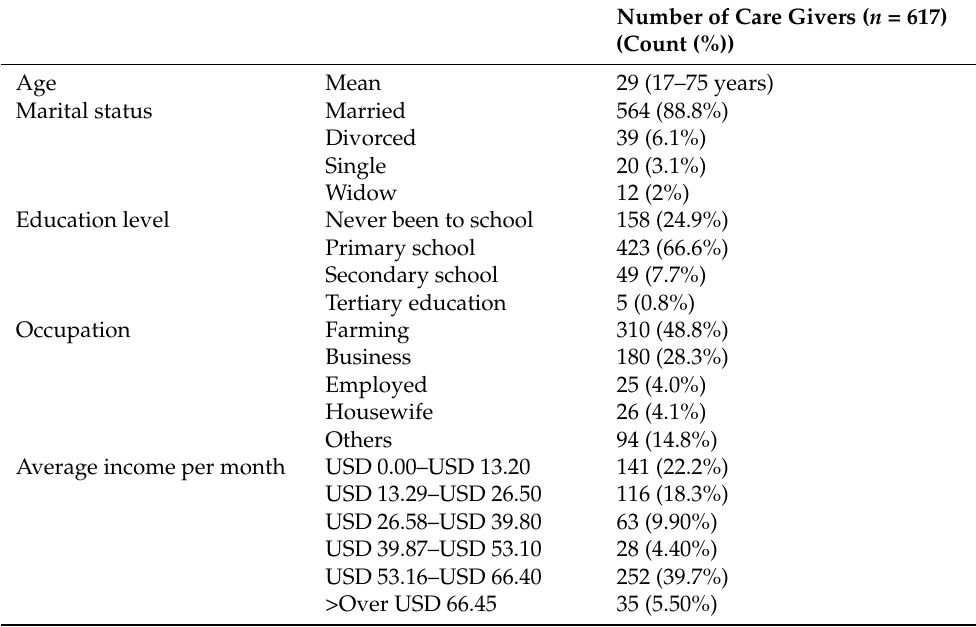
Table 2. Demographic characteristics of the child caregivers ( n =